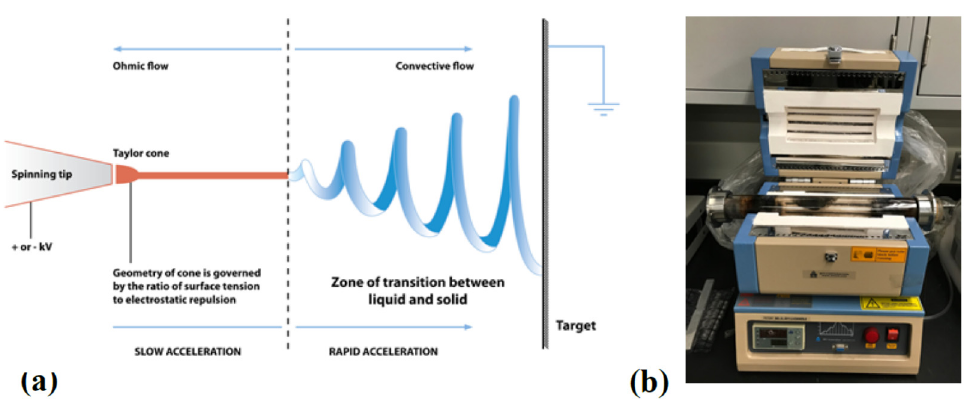
Figure 1. Fiber processing and pyrolysis instrumentation set-up: ( a ) electrospinning illustration; ( b ) heat treatment furnace.